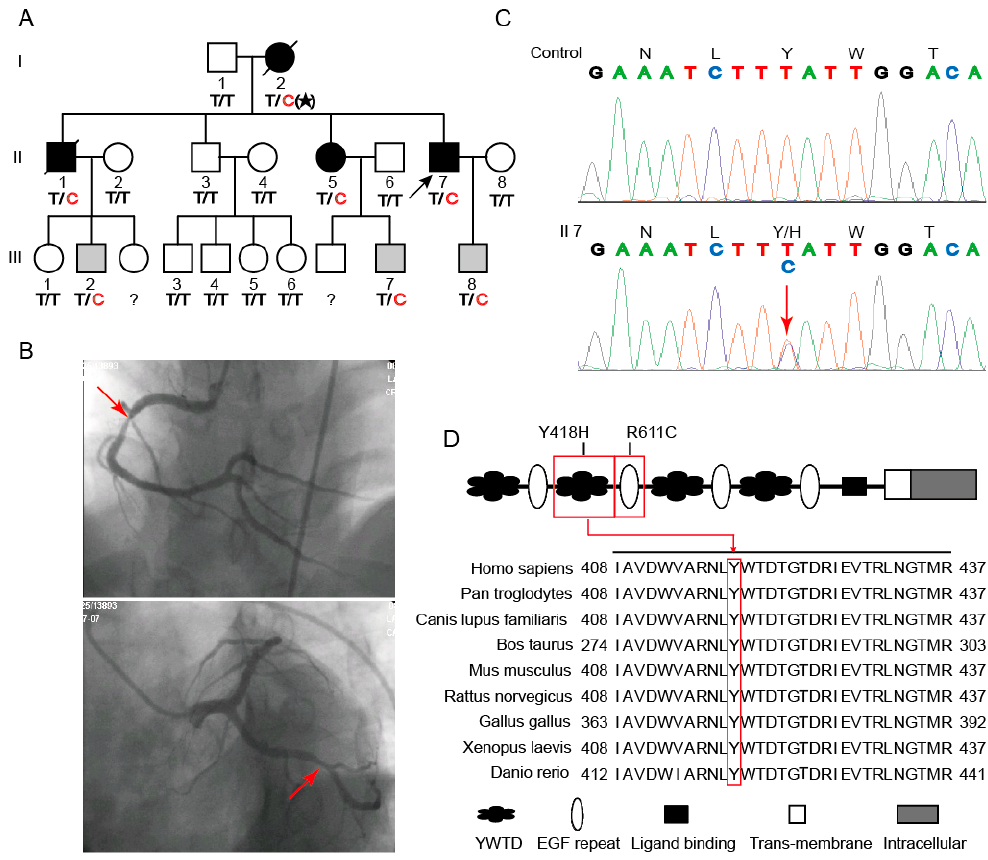
Figure 1. Novel mutation of LRP6 identified in a CAD pedigree. ( A ) Pedigree of the family with the LRP6 Y418H mutation. Numbered individuals correspond to those in Table 1. Circles represent females; Squares represent males; Proband is indicated by the arrow; Individuals with CAD are indicated by black symbols; Individuals without CAD are shown as unfilled symbols; Presymptomatic carriers are shown by symbols by gray symbols; Symbols with a slash through them indicate deceased subjects; Genotypes of the LRP6 mutation were shown below the symbols who were willing to participate in the study; Filled stars indicates that the genotype of subject I2 was speculated; Individuals who were not available for studied are indicated with question mark; ( B ) Coronary angiogram of the proband. The red arrows indicates the stenosis; ( C ) DNA sequence analysis for a segment of LRP6 exon 6 from a healthy control ( top ) and the proband ( below ). A red arrow points out a single base mutation in the proband, and it results in the substitution of histidine for tyrosine at codon 418; ( D ) Conservatism analysis by interspecies alignments. The mutation position is indicated with a red frame.